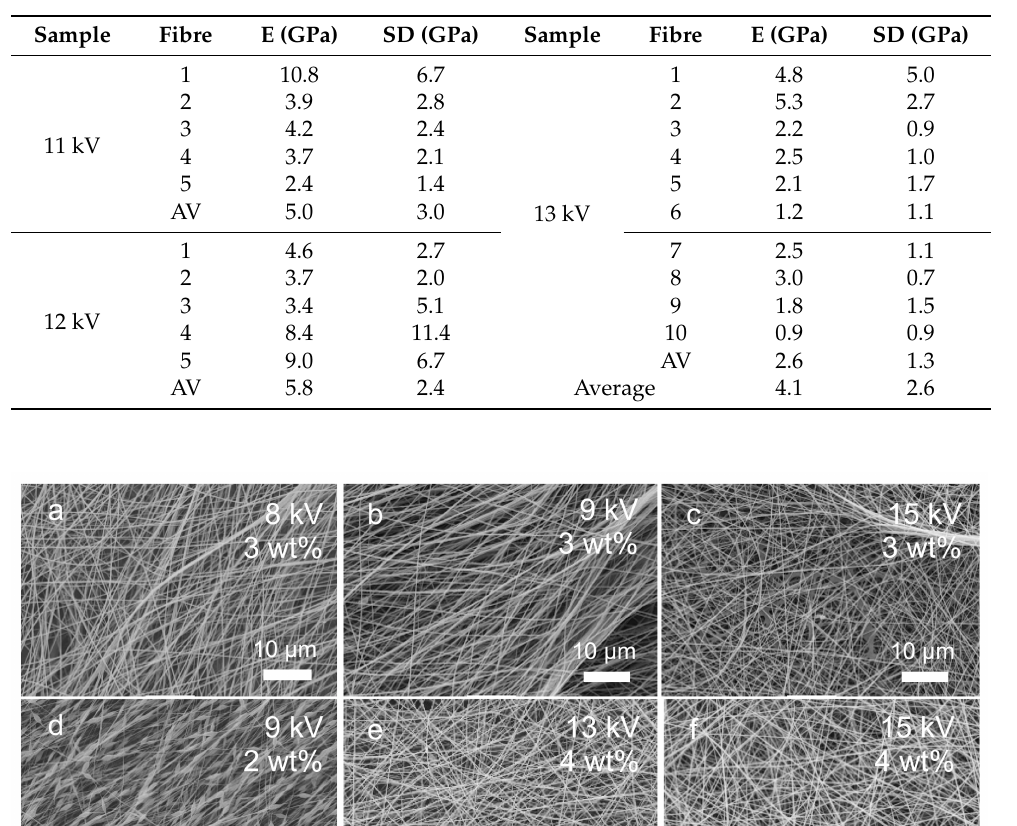
Table 1. Young’s modulus (E) measured with AFM nanoindentations on single electrospun fibres with standard deviations (SD) and average (AV) Young’s modulus obtained for each electrospinning voltage.